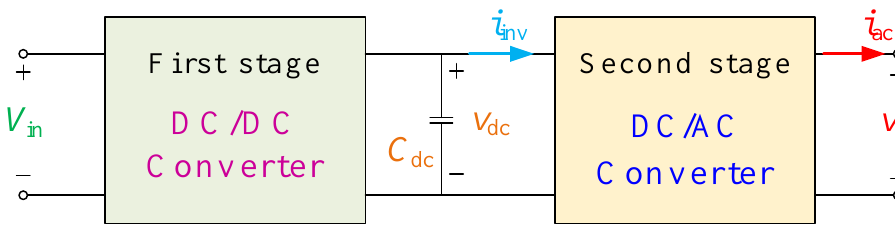
Figure 3. Topological structure of two-stage grid-connected system.